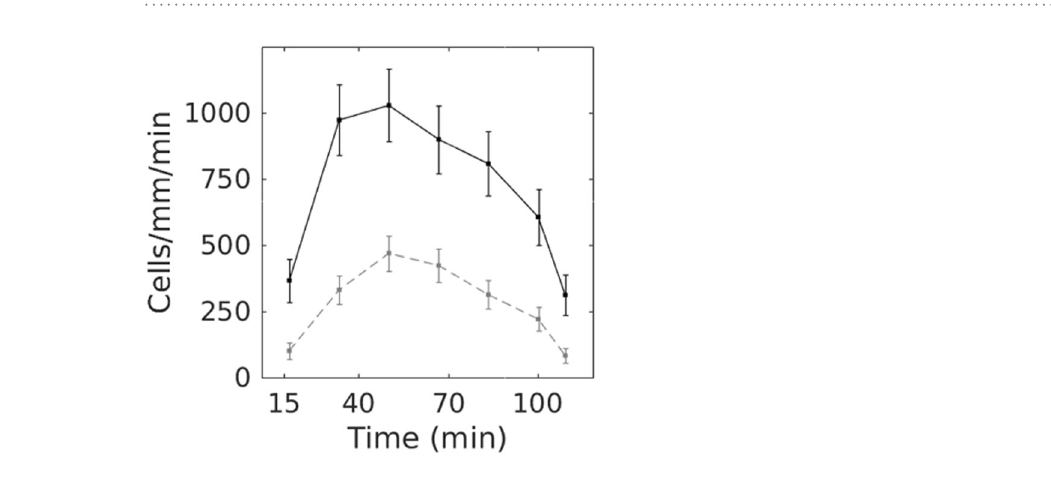
be investigated 51, 52 . Hoffman et al . 51 calculated expression of up to 71 000 receptors/cell, depending on receptor regulation, which is in the same order of magnitude of our calculated 2.4 × 10 4 substrate-bound molecule/cell